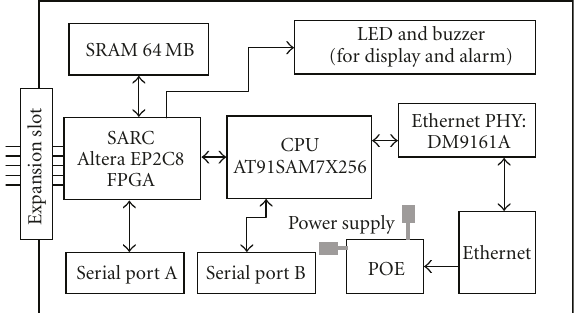
Figure 11: Block diagram of test board.